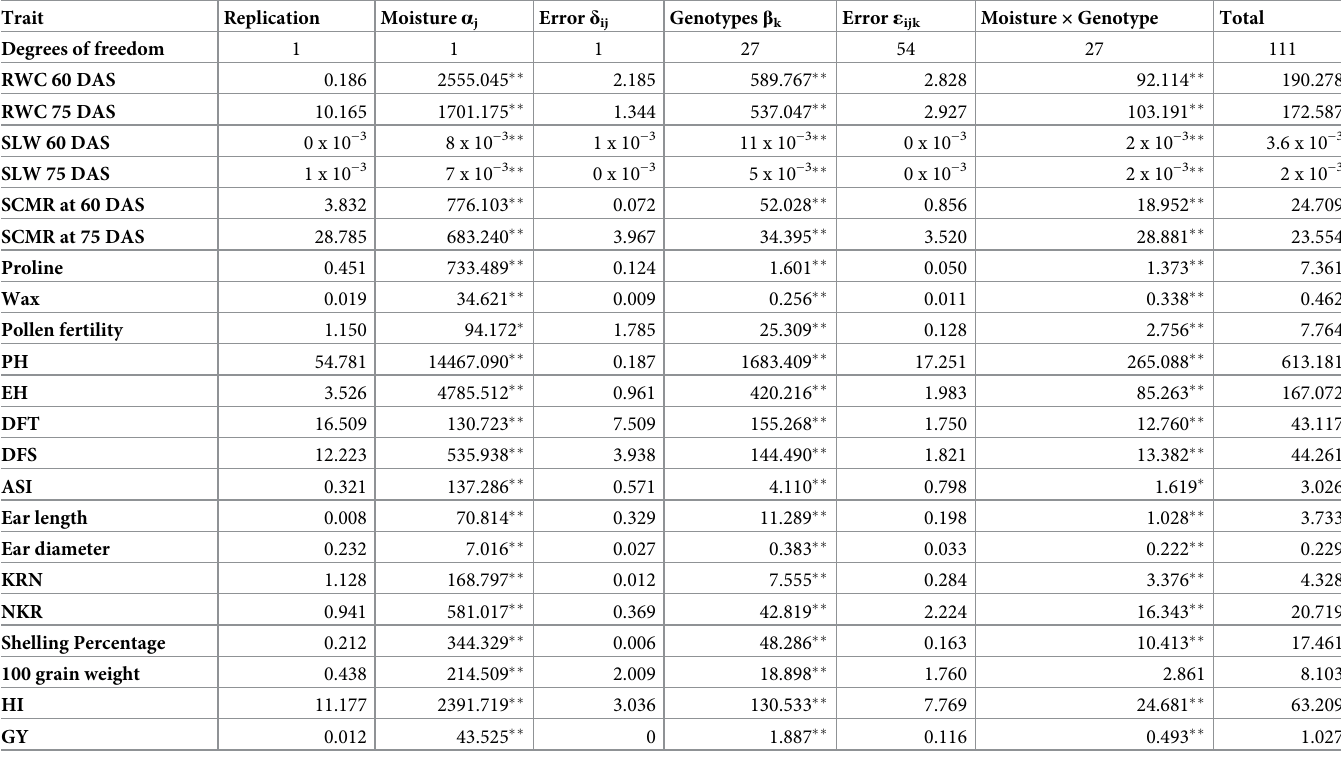
Table 3. Mean sum of squares due to different sources of variation for various traits of corn inbreds under water treatment.